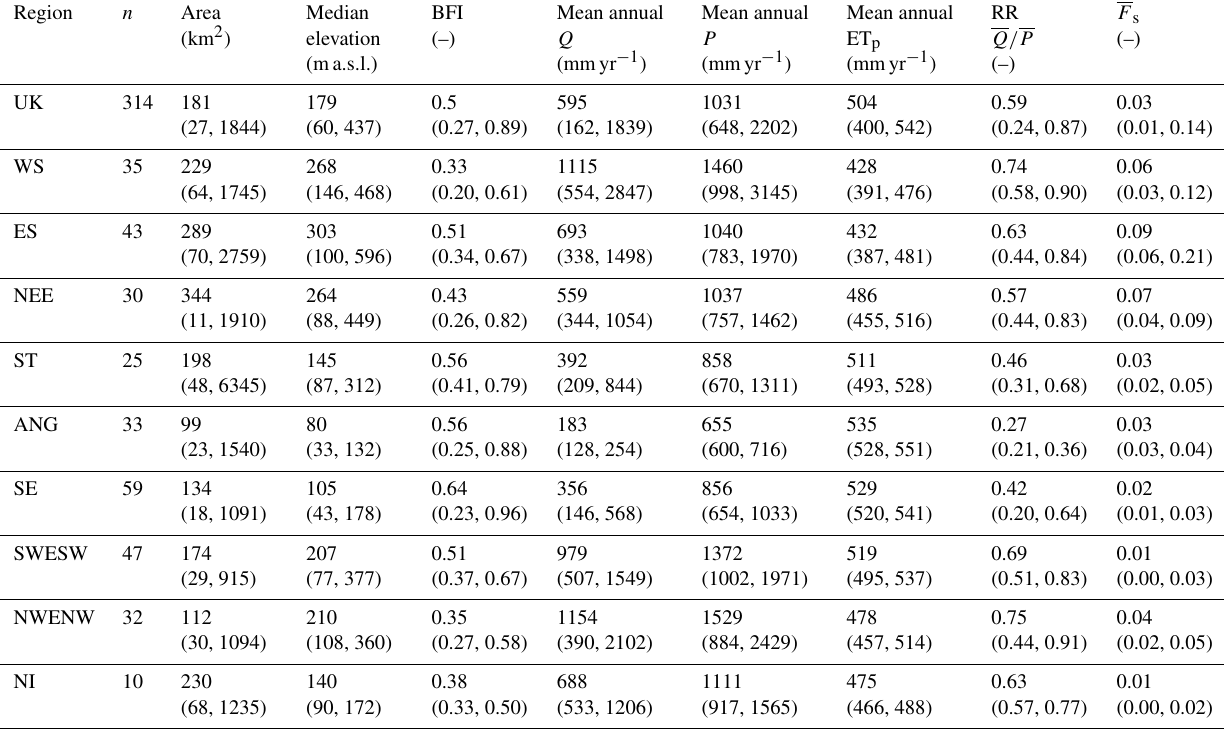
Table 1. Summary statistics of eight catchment characteristics for the UK and nine hydroclimate regions shown in Fig. 1. The median across n catchments within each region is given with the 5th and 95th percentile ranges in parentheses. Area, median elevation, and base flow index (BFI) were retrieved from the UK NRFA. Mean annual Q , P , and ET P were calculated over water years 1983–2014 using data in Sect. 2. RR is the runoff ratio and F s ∗ is the long term (water years 1983–2014) mean fraction of precipitation that has fallen as snow.